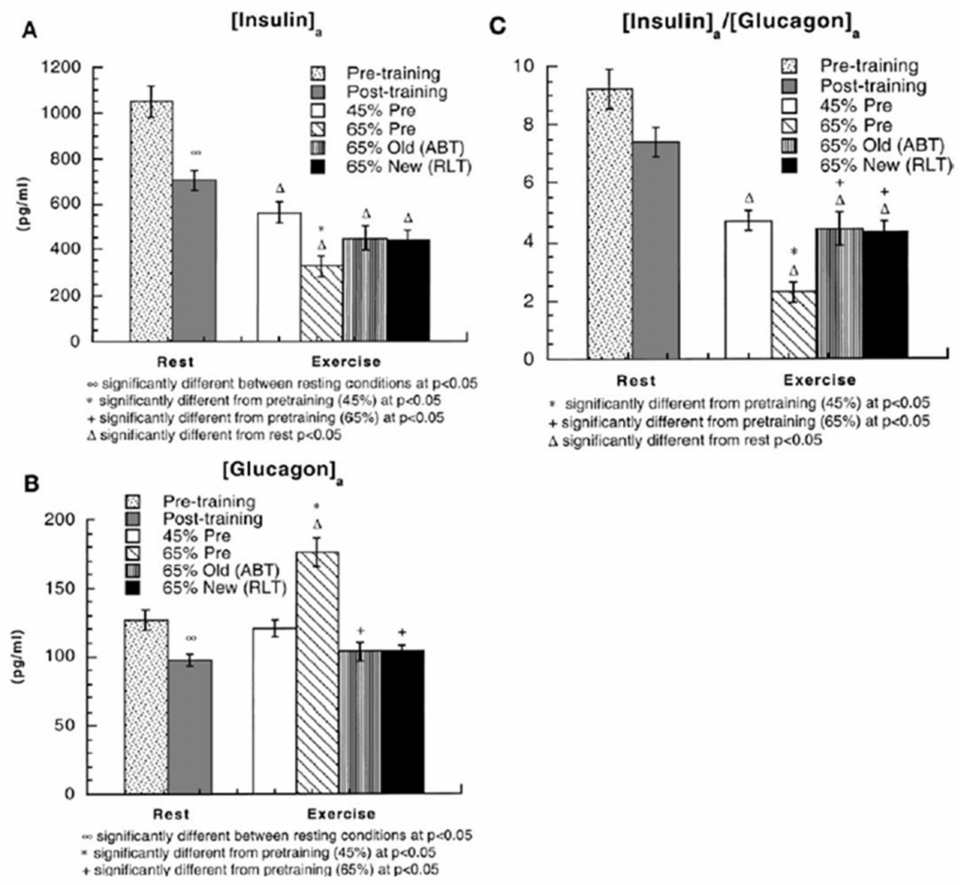
Figure 7. ( A ) arterial insulin concentrations ((insulin) a ) in healthy young men during rest and exercise, before and after training. Subjects (same as in Figures 3–6) were studied at 45 and 65% of peak rate of oxygen consumption (VO 2 peak) before 9 week of endurance training (45% pre and 65% pre, respectively) and then after training at same absolute power output that elicited 65% VO 2 peak before training (65% old (absolute, ABT)) and same relative power output that elicited 65% VO 2 peak after training (65% new (relative, RLT)). Values are means ± SE; n = 8–9. ( B ) Arterial glucagon concentrations ((glucagon) a ) during rest and exercise, before and after training. ( C ) Arterial insulin-to-glucagon ratios ((insulin) a / (glucagon) a ) during rest and exercise, before and after training. Endurance training has the e ff ect of decreasing insulin and glucagon levels and the I / G. Insulin levels declined during exercise; glucagon rose in the hard 65% VO 2 peak condition before training, but otherwise remained unchanged or declined slightly during exercise. See text for discussion. From